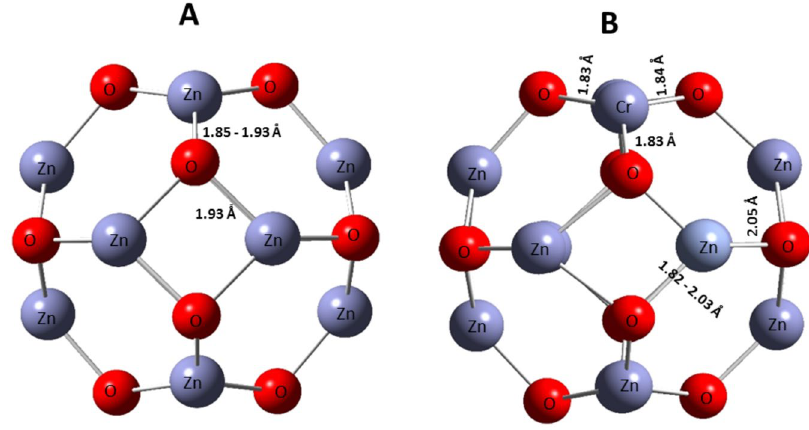
Figure 2. Optimized structures of ( A ) Zn 12 O 12 nano-cage, ( B ) Cr doped Zn 11 O 12 nano-cage.